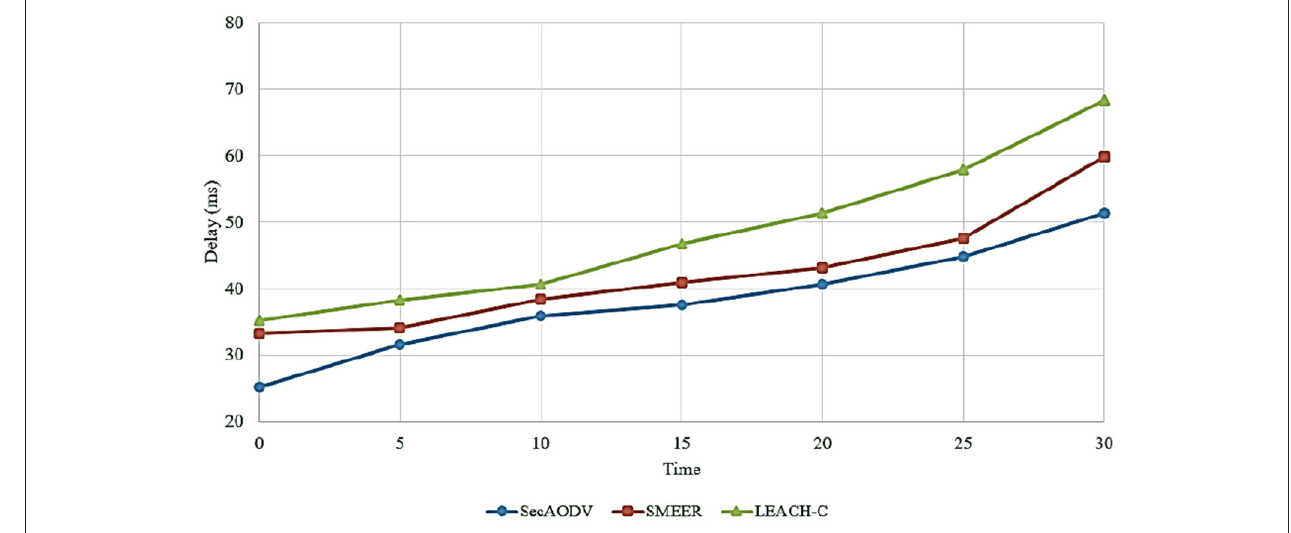
FIGURE 7 | Comparison of different method in terms of delay.